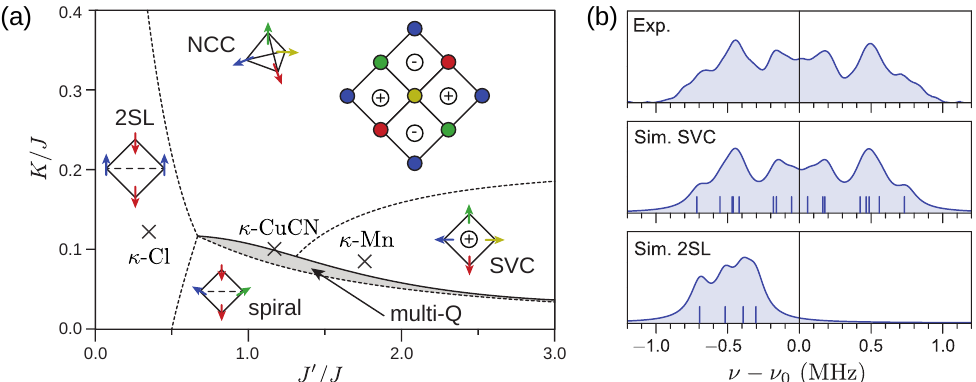
Figure 5. ( a ) Classical phase diagram for the four-spin ring-exchange on the anisotropic triangular lattice. Indicated are the locations for κ -(BEDT-TTF) 2 Cu[N(CN) 2 ]Cl ( κ -Cl), κ -(BEDT-TTF) 2 Cu 2 (CN) 3 ( κ -CuCN), and κ -(BETS) 2 Mn[N(CN) 2 ] 3 ( κ -Mn), based on ab-initio calculations in Refs. [12,51,64,67] (see Table 1). The depicted phases include the two-sublattice (2SL) Néel order, non-coplanar chi- ral (NCC) order, and spin-vortex crystal (SVC) order. For this phase diagram, the constraints J (cid:48) / J = J (cid:48)(cid:48)(cid:48) / J (cid:48)(cid:48) = K (cid:48) / K , K / J (cid:48)(cid:48) = 2, and | D | = | Γ | = 0 were enforced. ( b ) 13 C NMR spectra measured in Ref. [74] (“Exp.”) and simulated for hypothetical SVC and 2SL phases [51]. Figures adapted from Ref.